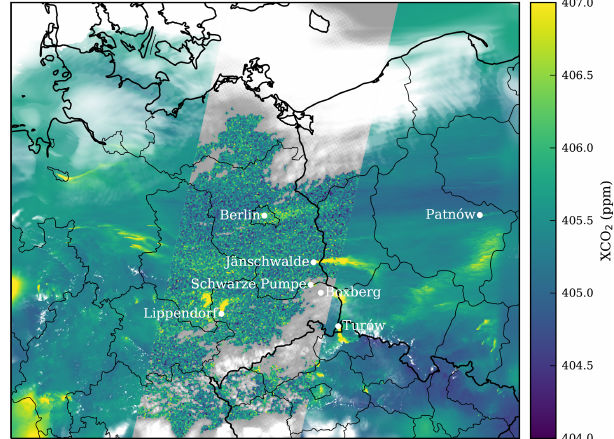
Figure 1. Simulated XCO 2 field on 23 April 2015 in the SMART- CARB model domain overlaid with an example of a 250km wide swath of the planned Sentinel CO 2 instrument (low-noise scenario). Missing CO 2 measurements are shown in gray. Cloud cover is over- layed in white, with transparency corresponding to total cloud frac-